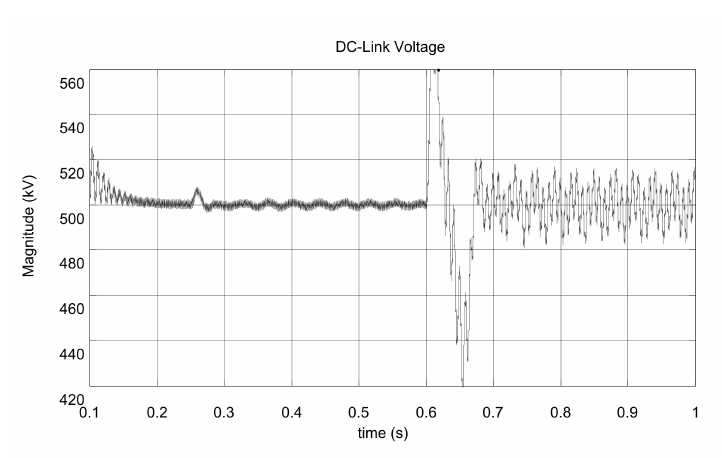
Figure 22. DC-link capacitor voltage under ‘type B’ voltage sag.